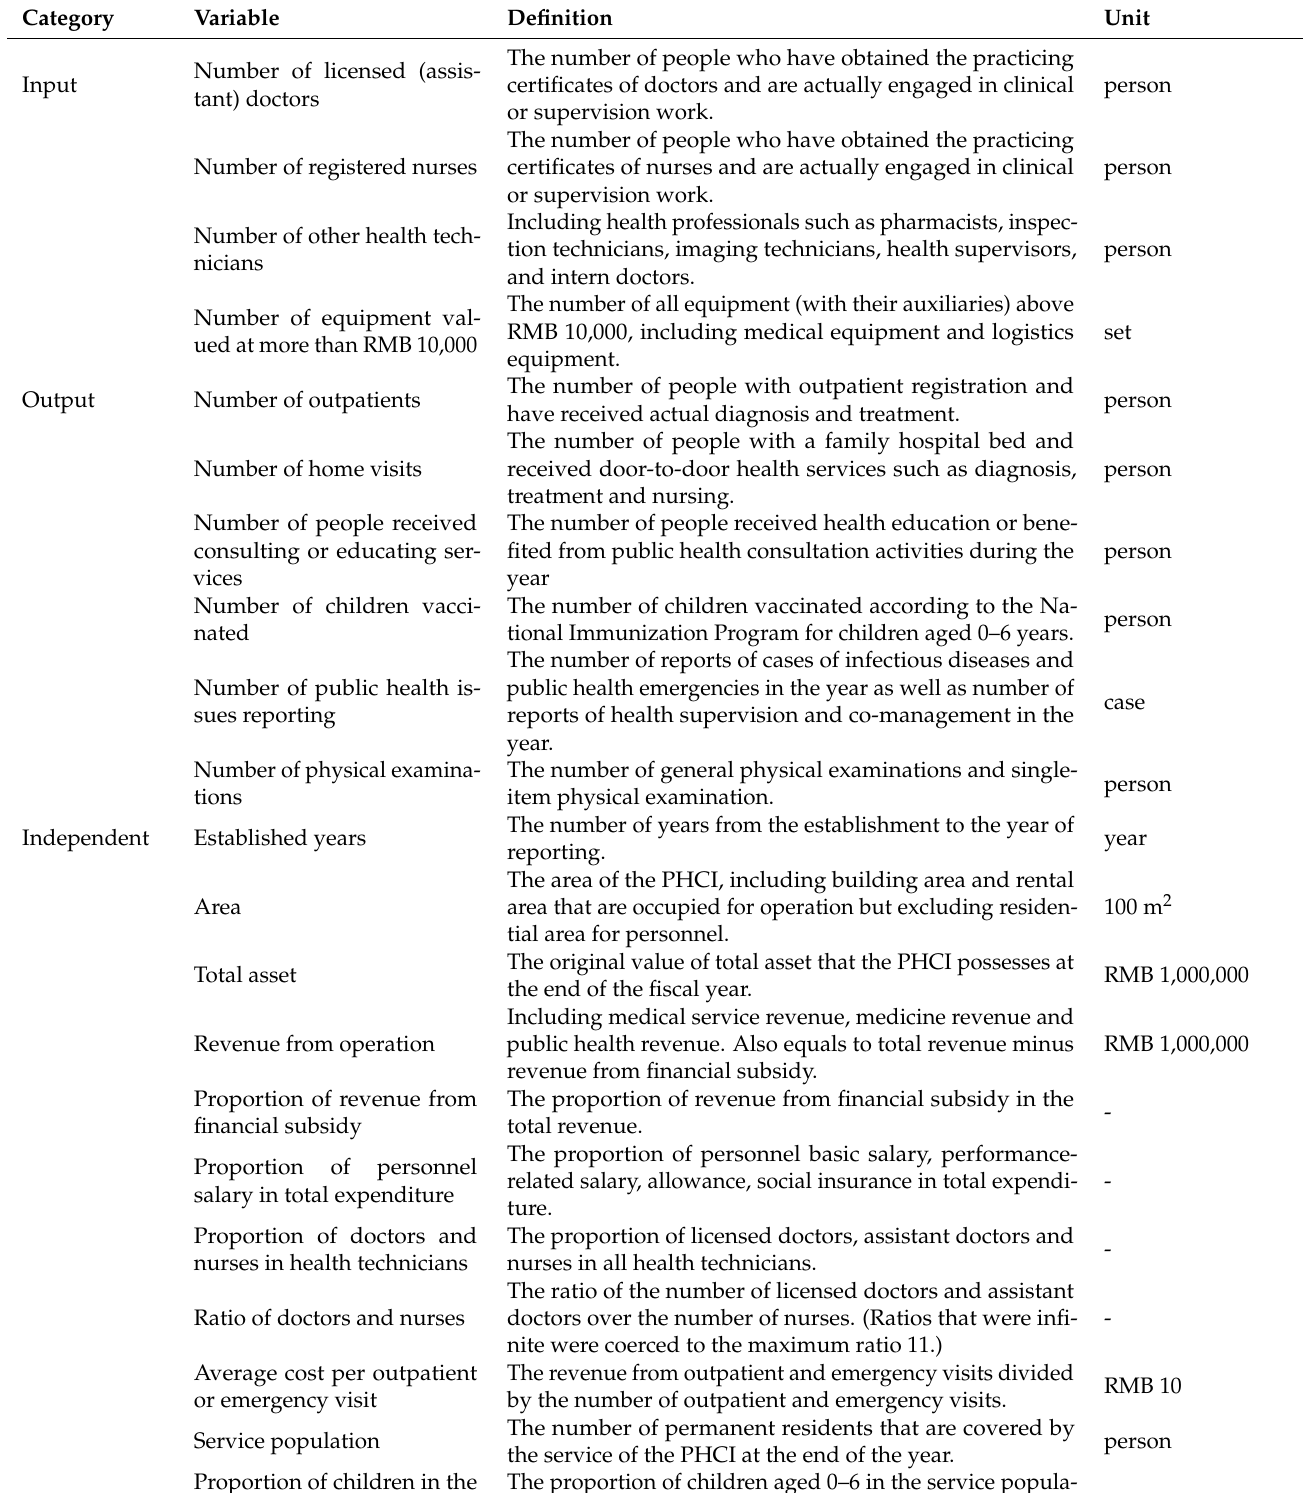
Table 1. Definitions of input, output, and influencing